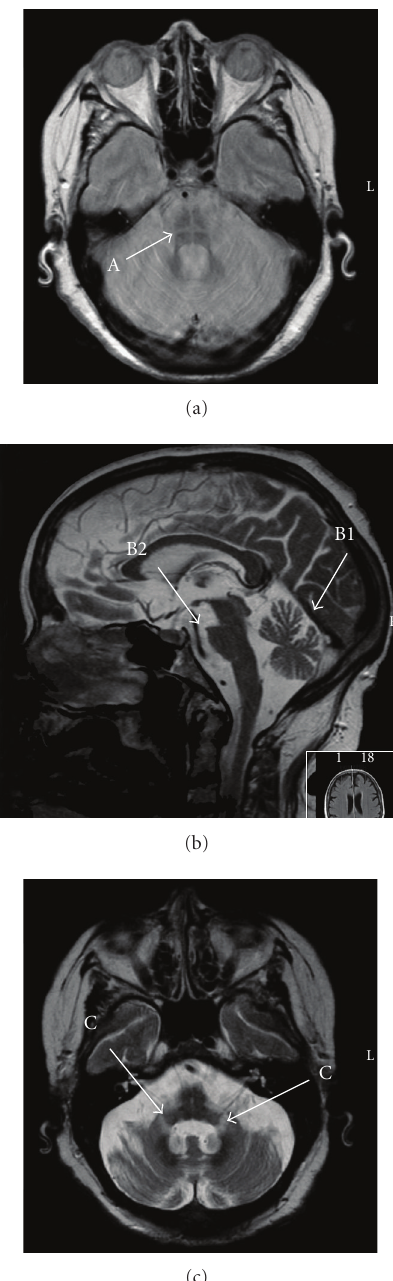
Figure 1: MRI imaging’s showing the reported alterations. (A) Hot cross sign. (B1) cerebellar and (B2) pons atrophy. (C) Atrophy of middle cerebellum